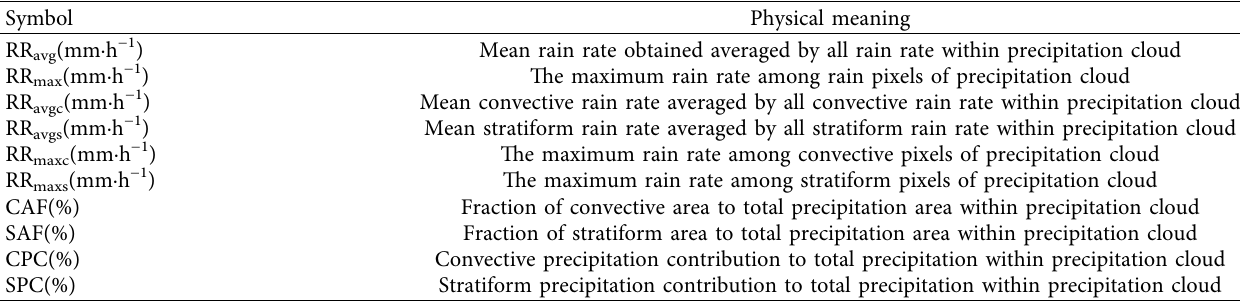
Table 2: The definition of physical parameters of precipitation clouds.